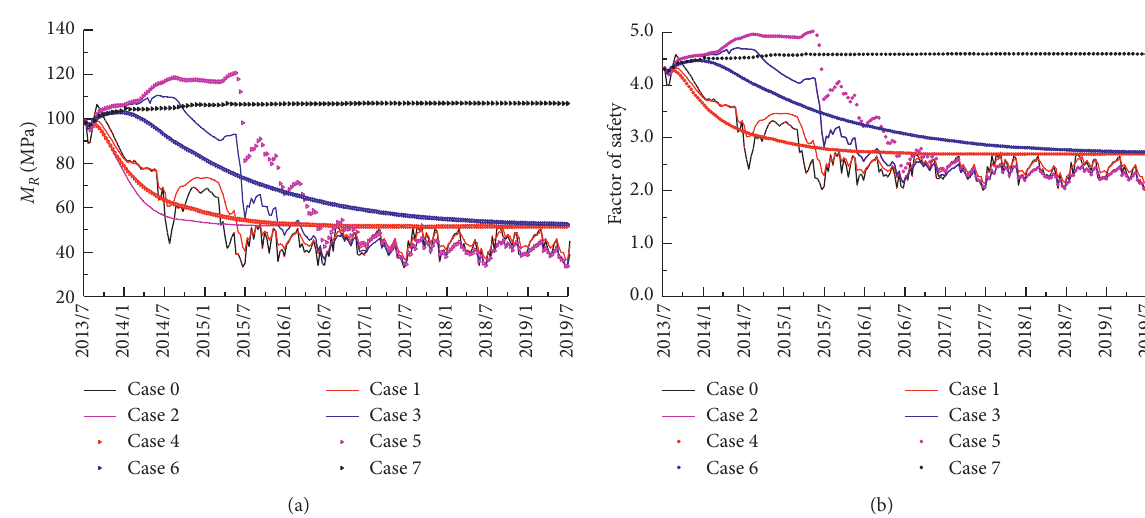
Figure 13: Variation of resilient modulus and factor of safety over time: (a) resilient modulus; (b) factor of